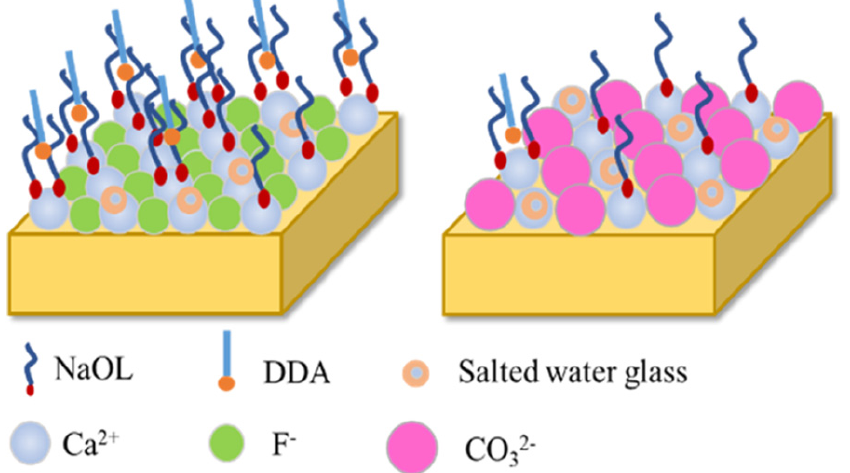
Figure 7. Schematic of the fluorite/calcite surface with reagents [12].